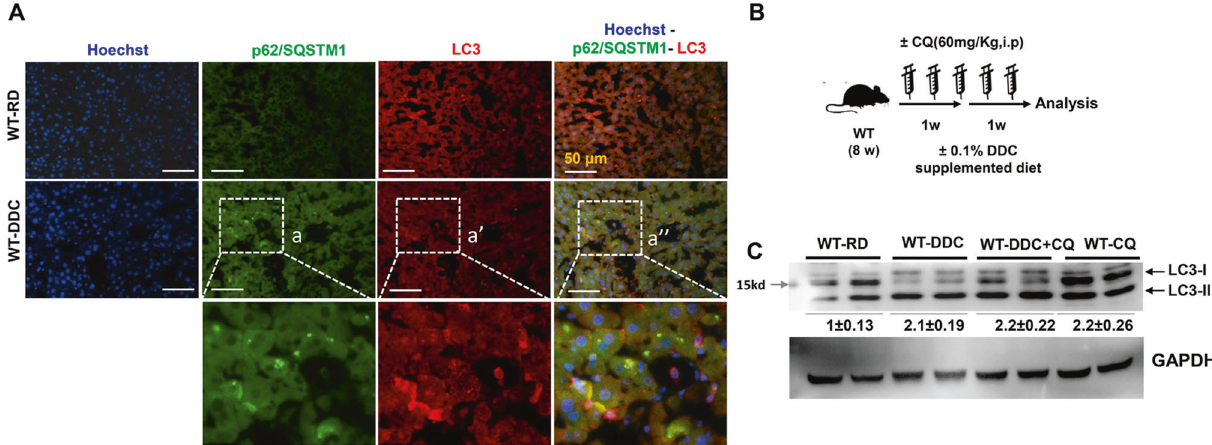
Fig. 3 Autophagy fl ux is impaired by DDC. A Co-immunostained for p62 and LC3 in liver section prepared from wild type mice fed with regular diet (RD) and 2 weeks of DDC diet. The a, a ’ , and a ” represents the enlarged images from the respective images from DDC diet fed wild type liver. Scale bars: 50 μ m. B Schematics of CQ administration to Regular diet (RD) or 2 weeks of DDC diet fed wild type mice. C Total liver lysates were analyzed by immunoblotting for LC3, and GAPDH. Protein band intensity was normalized to GAPDH band intensity. Data are expressed as the